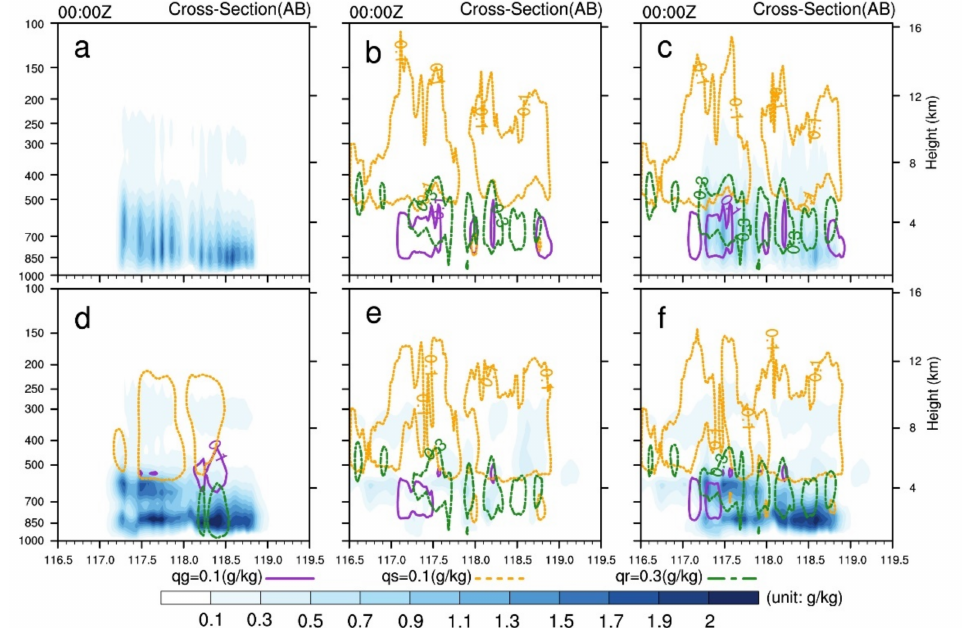
Figure 6. Vertical cross-sections of analysis increments of q v (blue shaded contour lines), q g (dark orchid contour lines), q s (orange contour lines) and q r (forest green contour lines) from single-analysis experiments at 0000 UTC 30 June 2018 (analysis time) along line AB in Figure 3a. ( a , d ) Lightning data assimilation by 3DVAR and hybrid 3DEnVAR, ( b , e ) radar data assimilation by 3DVAR and hybrid 3DEnVAR, and ( c , f ) the combined lightning and radar data assimilation by 3DVAR and hybrid